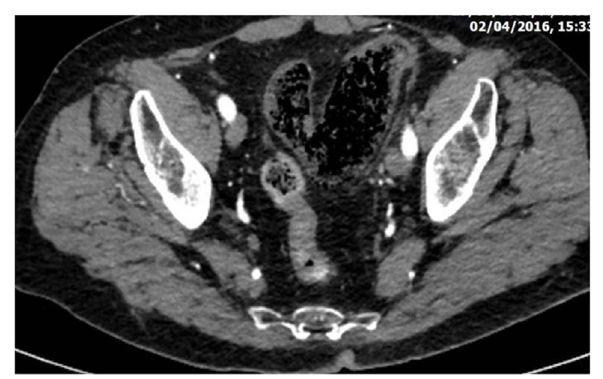
FiGURe 2 | Abdominal CT revealing diffuse dilatation of the sigmoid with gas infiltration of its submucosa due to severe whole thickness ischemia (the gangrenous